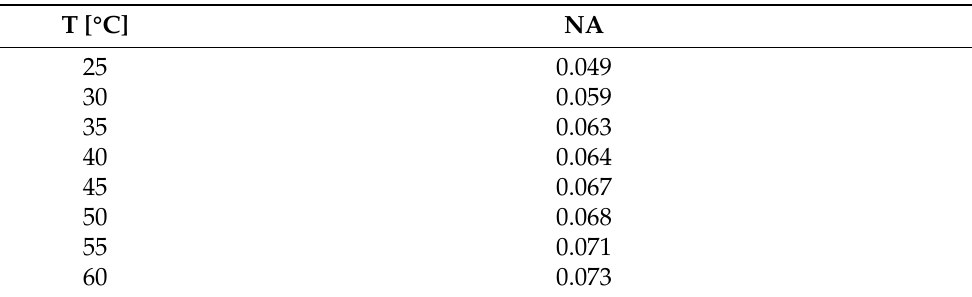
Table 2. Change of the numerical aperture with increasing temperature calculated from the refractive indices of Table